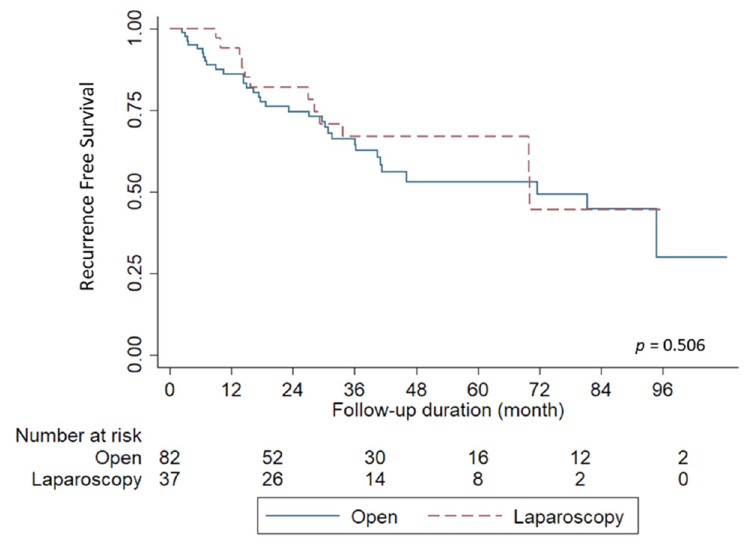
Figure 4. Comparison of recurrence free survival. Patients with liver resection showed comparable outcomes between laparoscopic approach and conventional open method ( p = 0.506).